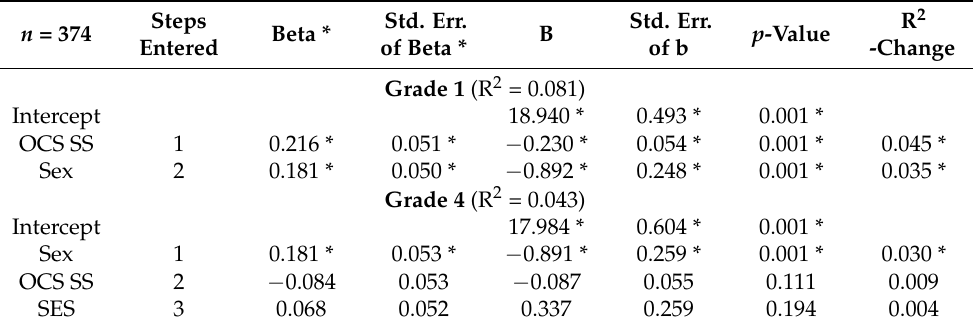
Table 5. A stepwise regression analysis of the variance explained by grade 1 and grade 4 OCS SS on grade 7 participants’ CAMSA time score, controlling for SES and